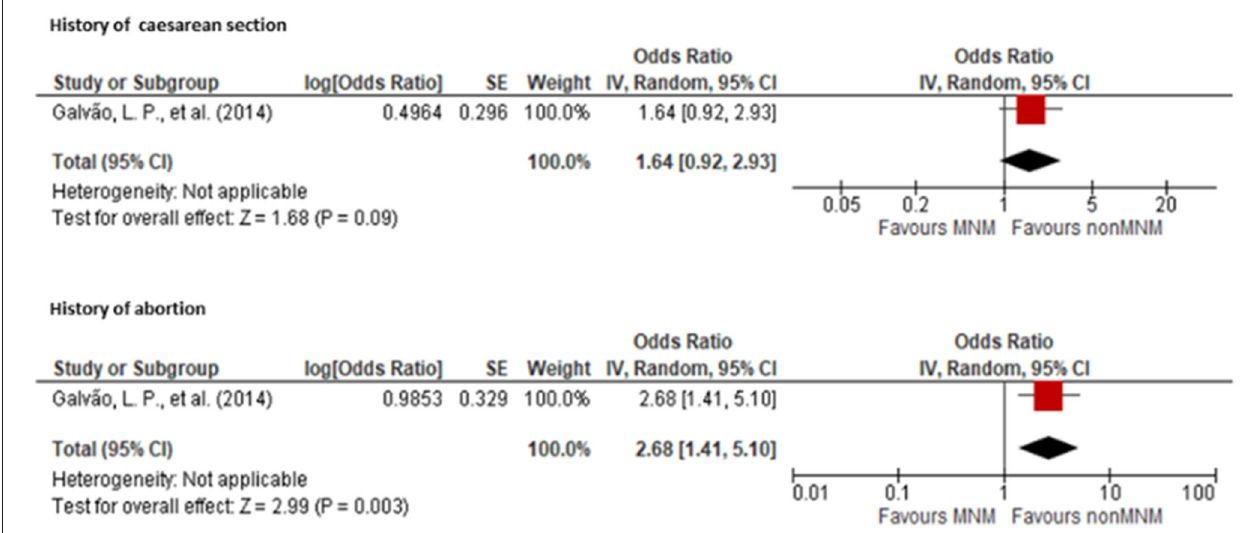
FIGURE 7 | Forest plot showing the association of history of cesarean section and abortion with maternal near miss.